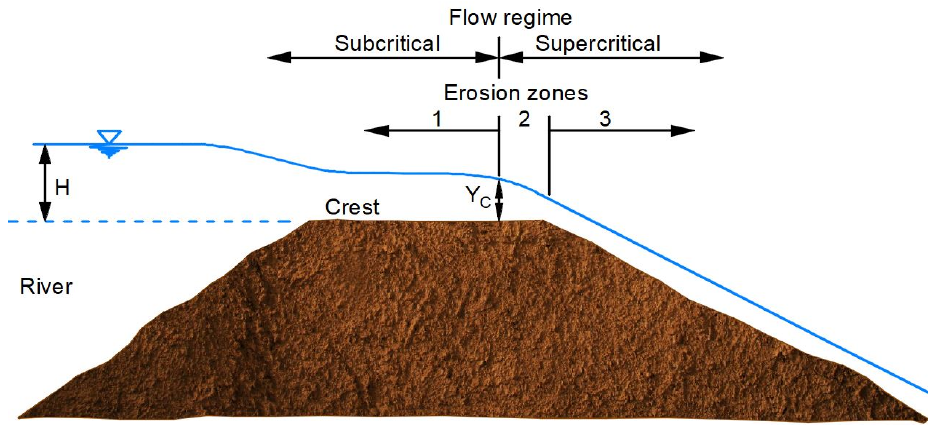
Figure 5. Flow regimes during overflow of a dam, redrawn from [65].